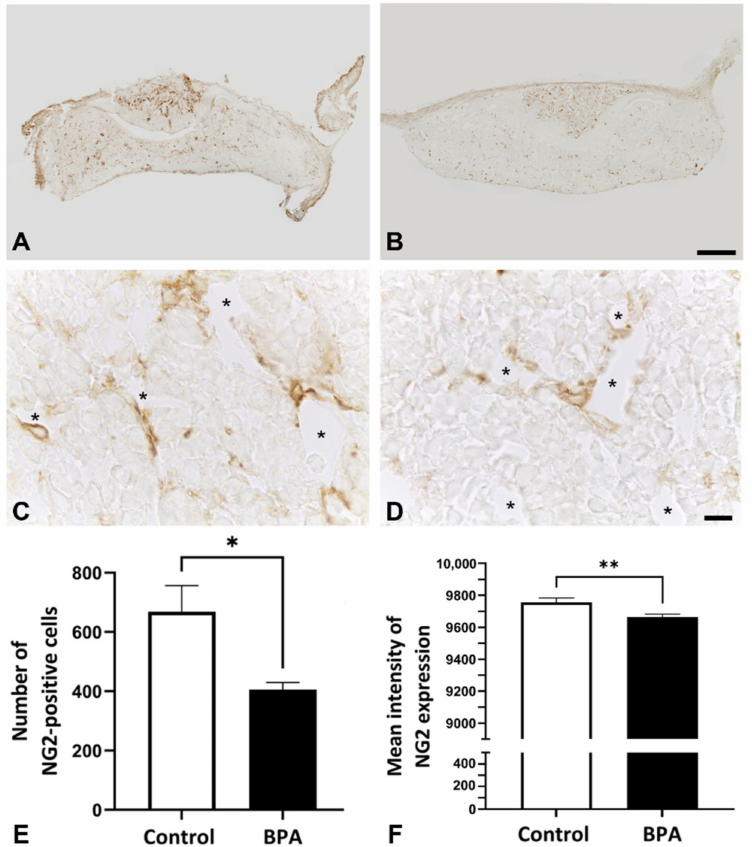
Figure 1. Immunohistochemistry of NG2 on postnatal Day 1 in the anterior pituitary glands of control rats (( A , C ): higher magnification view of ( A )) and BPA-treated rats (( B , D ): higher magnification view of ( B )). The number ( E ) and mean intensity ( F ) of NG2-positive cells decreased in the BPA-treated group. Note: the capillary lumens (asterisks), * p < 0.05, ** p < 0.01. Scale bars: 100 µ m ( A , B ); 10 µ m ( C , D ).